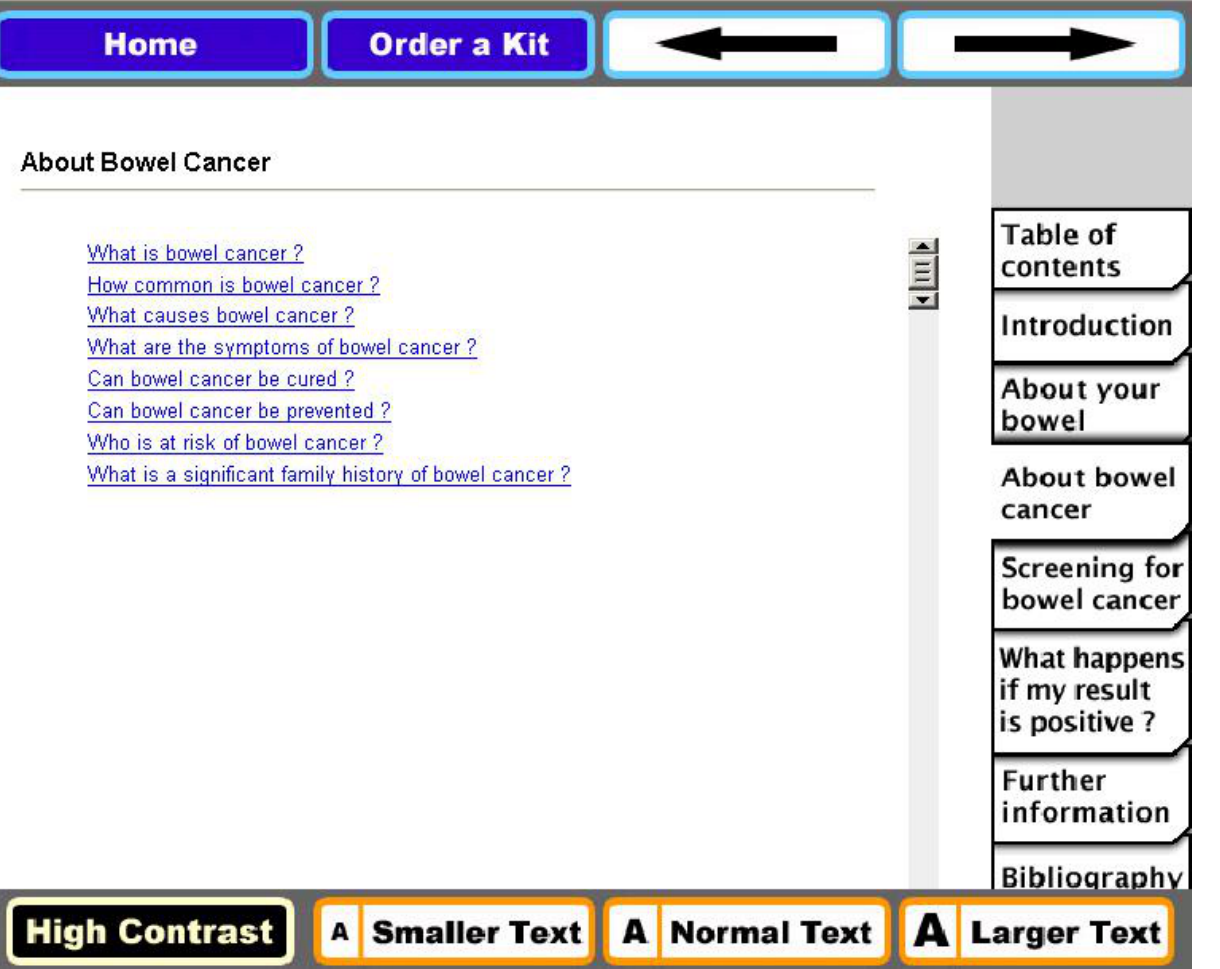
Figure 2. Screenshot of Web-based educational